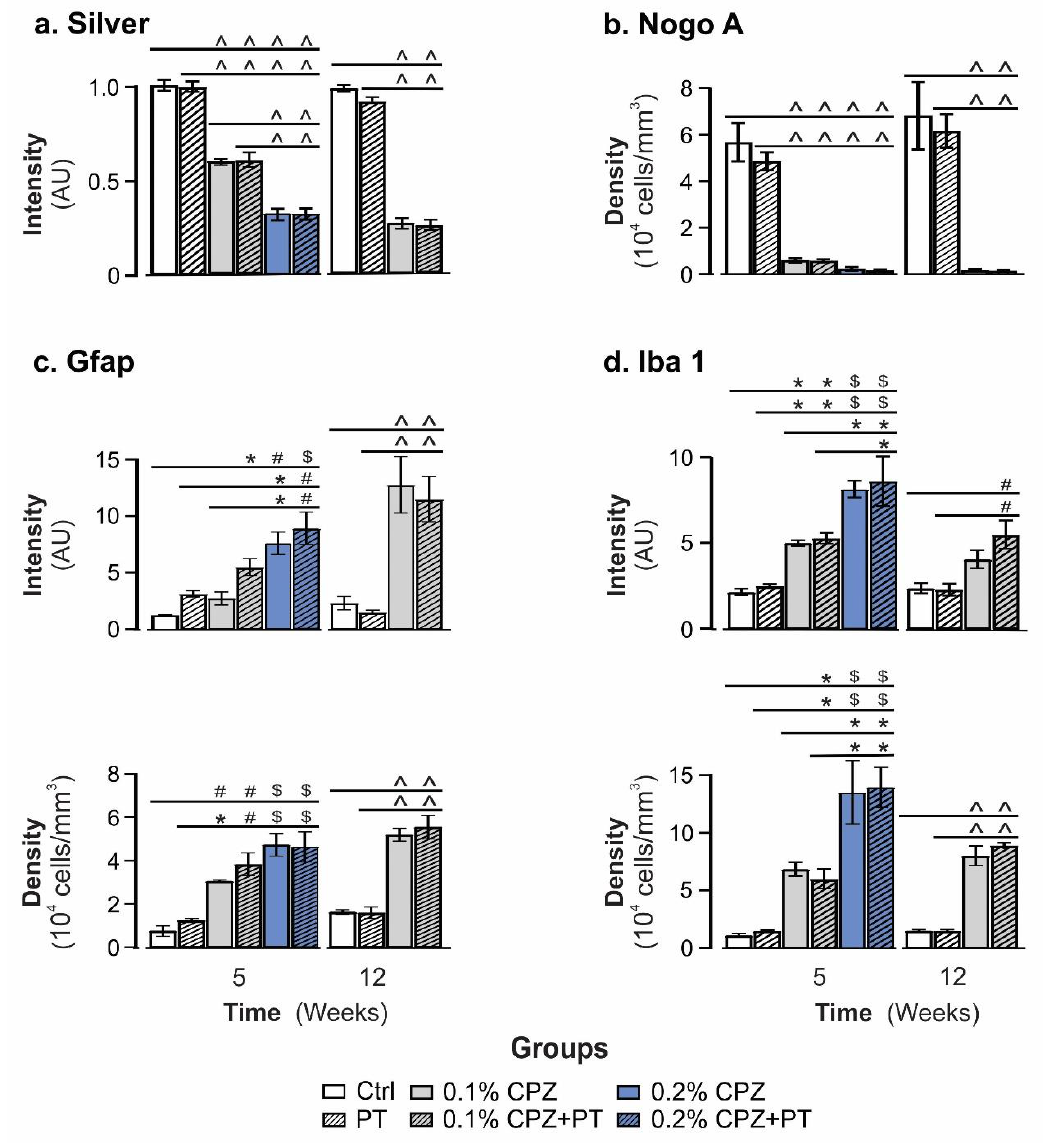
Figure 2. Quantification of demyelination, cell death and gliosis in the midline corpus callosum. ( a ) Silver staining. CPZ-feeding( ± PT) led to significant demyelination and reduced silver staining intensity at 5 and 12 weeks. PT alone had no e ff ect. Feeding 0.1% CPZ for longer (12 weeks) produced a comparable demyelination to that seen with 0.2% for 5 weeks. ( b ) Nogo A. CPZ-feeding( ± PT) led to significant oligodendrocytosis with 0.1% CPZ was as e ff ective as 0.2% CPZ at either time point. PT alone had no e ff ect. ( c ) Gfap. Staining intensity increased in a dose dependent manner, in the CPZ( ± PT) treated groups and this was associated with an increase the number of Gfap positive astrocytes at both time points. PT only did not evoke a Gfap response. ( d ) Iba 1. Increased Iba 1 fluorescence intensity and number of Iba 1 positive microglia were seen in both 5- and 12-week groups. PT alone produced no microglial response. Data are presented as mean ± SEM. One-way ANOVA and Tukey post hoc analysis was used to determine di ff erences among groups (* p < 0.05, # p < 0.01, $ p < 0.001 and ˆ p < 0.0001). Quantitation based on analysis of 5–9 sections / animal, 3–5 animals /